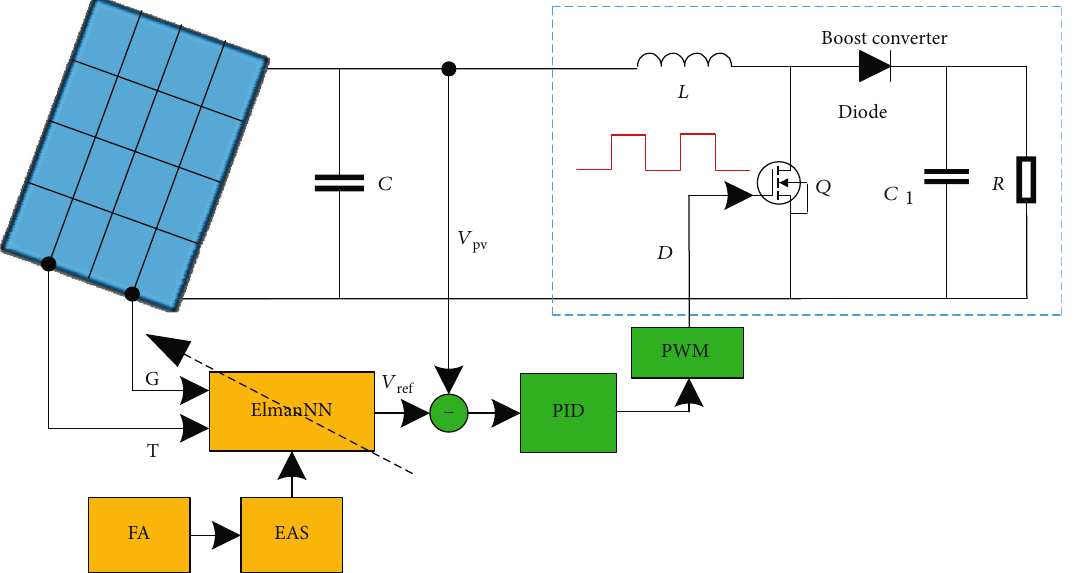
Figure 5: Schematic diagram of the FA-EAS-ElmanNN algorithm.